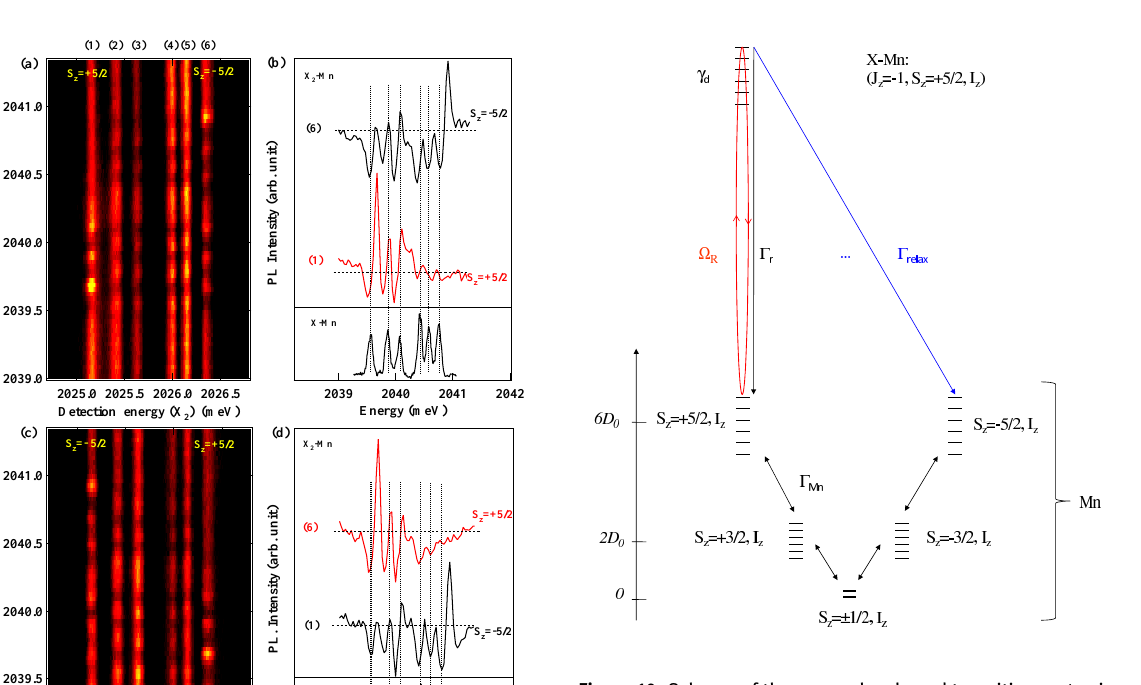
Figure 10: Scheme of the energy levels and transitions rates in- volved in the resonant excitation model (see text). (cid:126) Ω R is the en- ergy coupling with the laser, 𝛾 d = 1/ τ d is a pure dephasing rate of the exciton, Γ Mn = 1/ τ Mn is the spin relaxation rate of the Mn, Γ r = 1/ τ r is the optical recombination rate of the exciton. A relax- ation rate of the exciton-Mn complex Γ relax = 1/ τ relax is used for an effective description of the optical pumping effect.